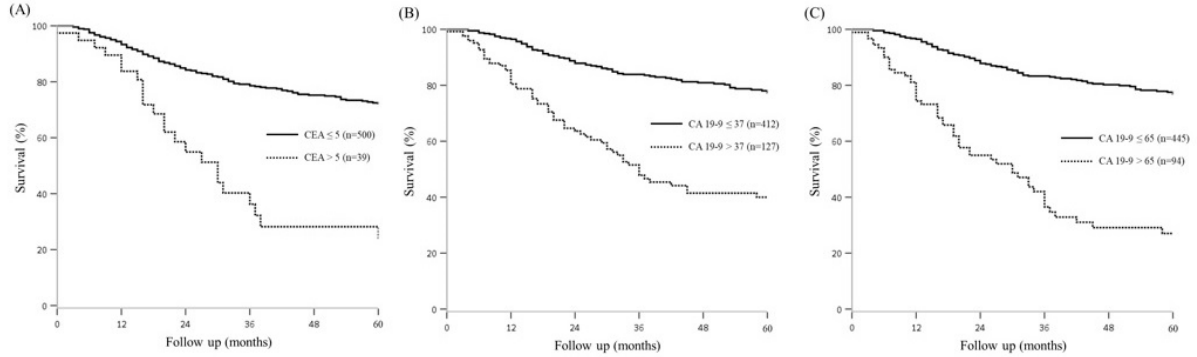
Figure 3. Survival graph according to CEA level and CA 19-9 level. Kaplan-Meier curves for patient following cholecys- tectomy 5 YOSR of the CEA ≤ 5 cases was 72.1% compared to 24.2% for the CEA > 5 cases ( p < 0.001) ( A ). 5YOSR of the CA 19-9 ≤ 37 cases was 77.2% compared with 37.8% for the CA 19-9 > 37 cases ( p < 0.001) ( B ). 5 YOSR of the CA 19-9 ≤ 65 cases was 76.8% compared with 24.0% for the CA 19-9 > 65 cases ( p < 0.001) ( C ).